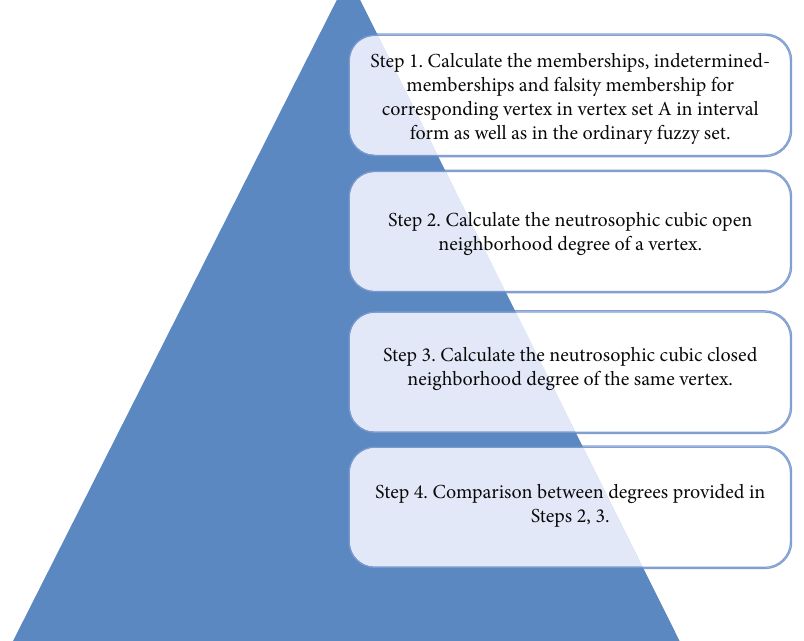
Figure 11: Frame diagram of the proposed